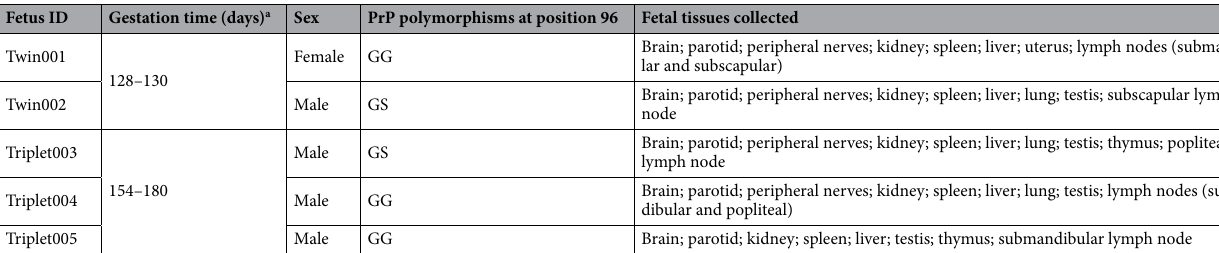
Table 1. White-tailed deer fetuses (twins and triplets) collected from two prion infected does. a Estimated gestation time by forehead-rump length measurements and hair pigmentation patterns.